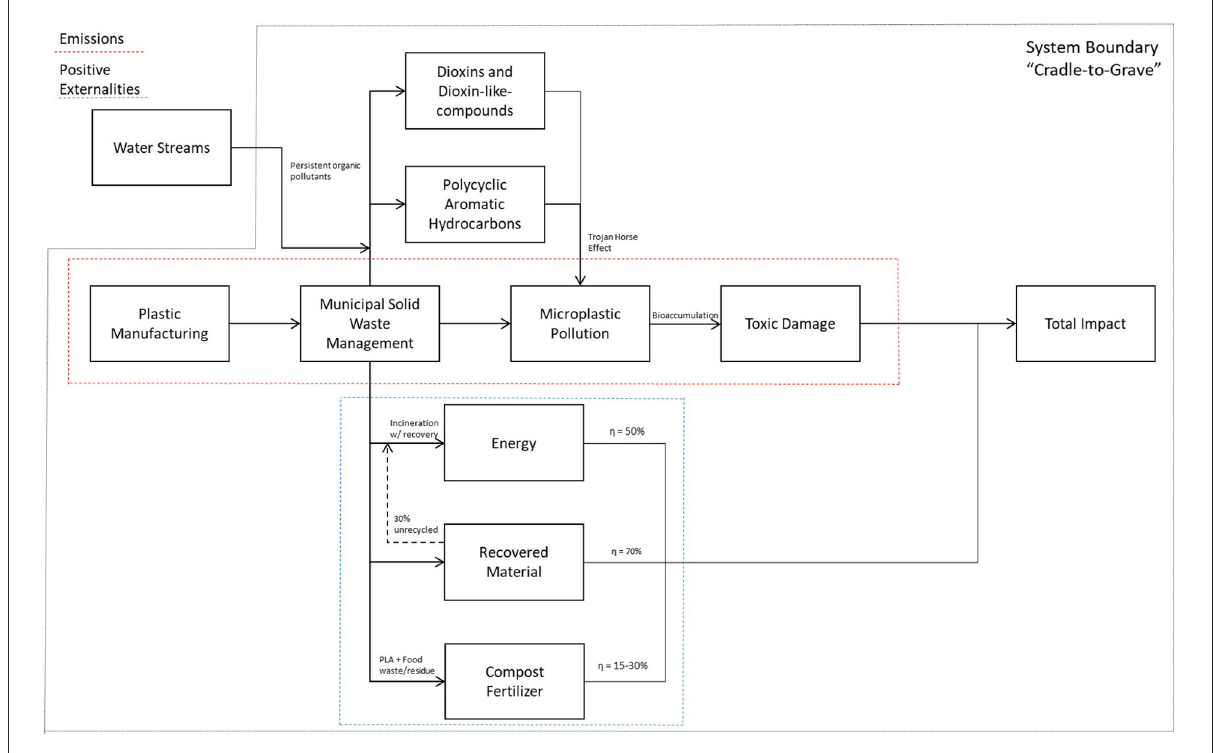
FIGURE3 Impact flow diagram and polluters pay—LCA system